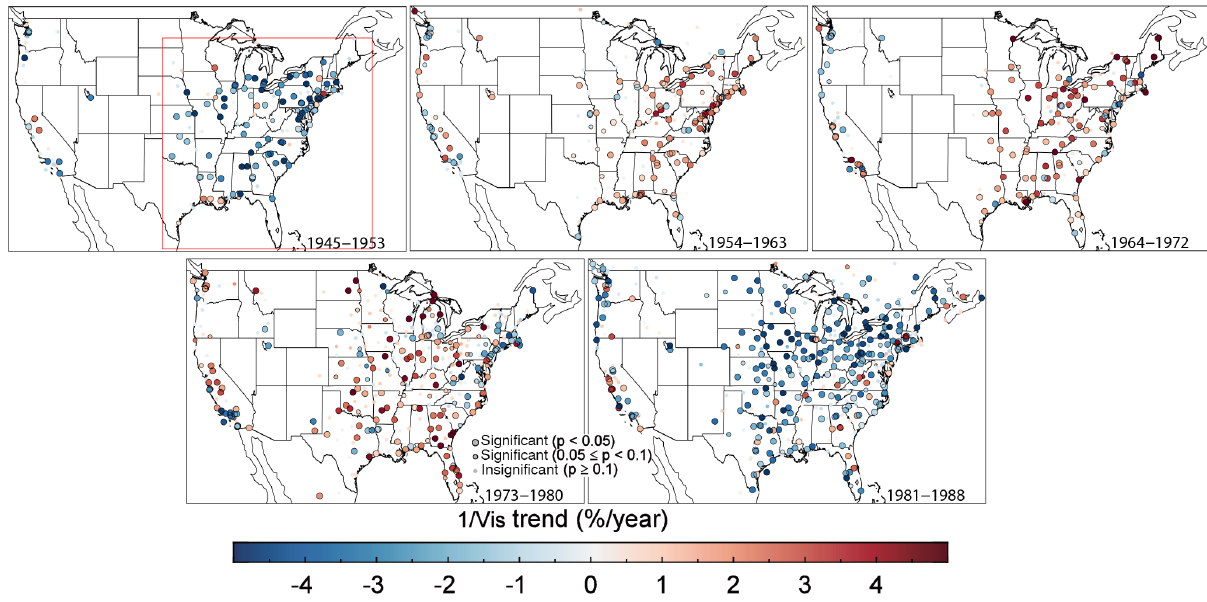
Figure 7. Spatial distribution of relative trends in 1/Vis over the US for 1945–1988. Larger colored points with black outline indicate trends with at least 95% significance, smaller colored points with black outline represent trends with 90–95% significance, and colored points without outline indicate insignificant trends. The red rectangle defines the eastern US region for composite time series analysis in Fig. 8.